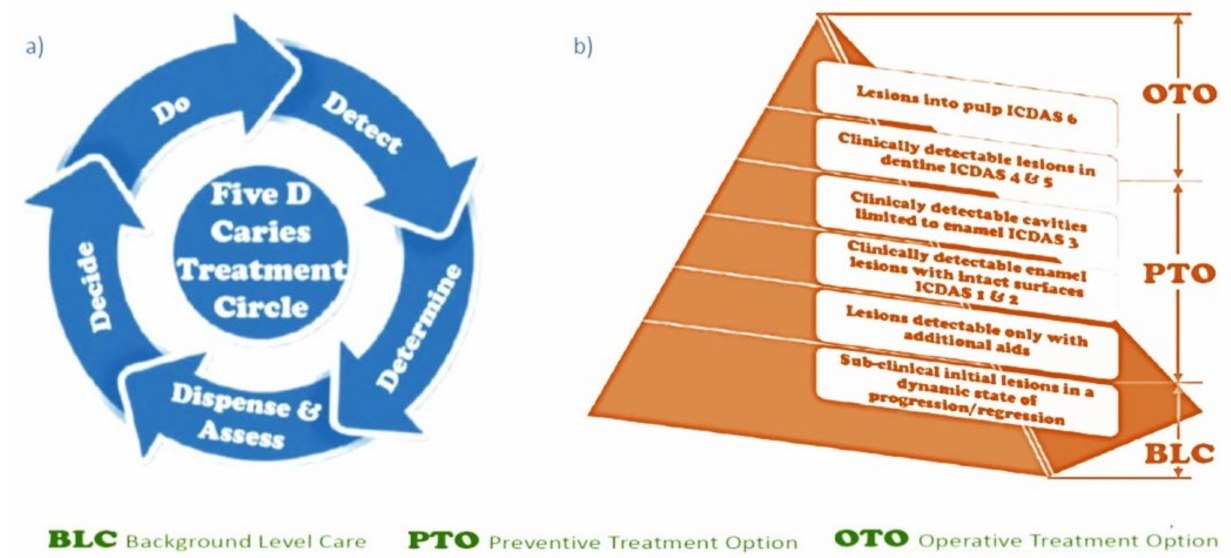
Figure 7. Diagram: ( a ) the 5D caries management cycle rules (CMCR), ( b ) the caries development pyramid